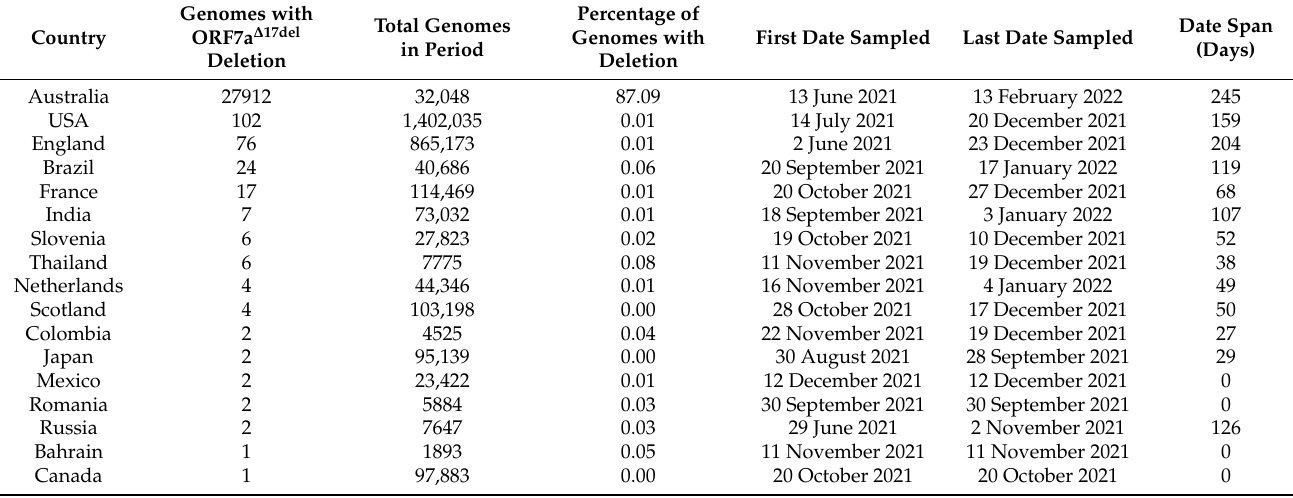
Table 2. All countries that generated genomes possessing the deletion that characterised the Aus- tralian Delta outbreak (ORF7a ∆ 17del ) during the outbreak time period, as determined by analysis of all Delta genomes in GISAID clade GK (as of 31 May 2022). The genomes either possessed ORF7a ∆ 17del as the sole deletion in ORF7a, or it was one of two or more deletions in the gene. The table is ranked by the number of genomes with ORF7a ∆ 17del . The percentage of Delta genomes submitted to GISAID during the time period that had ORF7a ∆ 17del is given to two decimal places. Note: a date span of 0 days suggests that genome(s) were collected on a single date. Accession numbers for all samples analysed for this panel are in Table S1 and